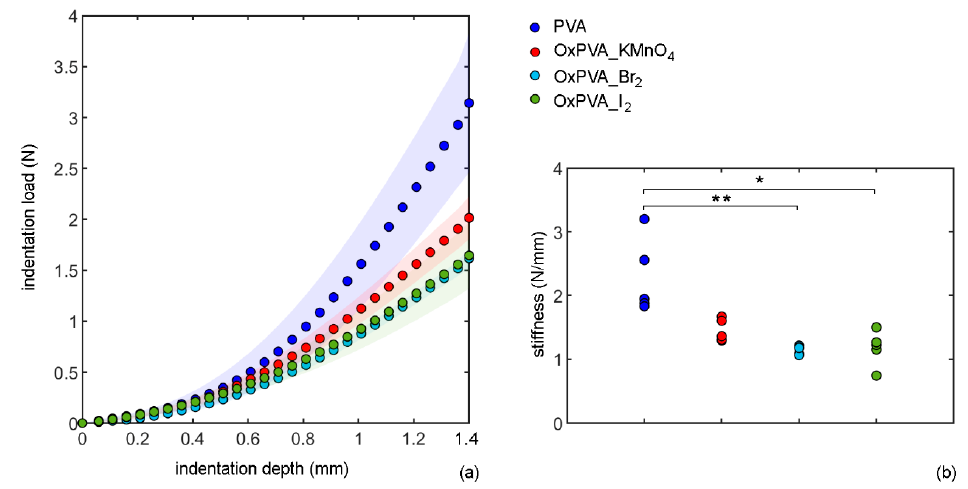
Figure 2. Results of indentation tests of native and oxidized PVA hydrogels: ( a ) indentation load (mean and confidence interval) vs. depth; ( b ) values of stiffness (N/mm) for each sample of native and oxidized PVA. Significant differences among hydrogels are indicated by one (*) or two (**) asterisks, respectively with p -value < 0.05 and p -value < 0.01.